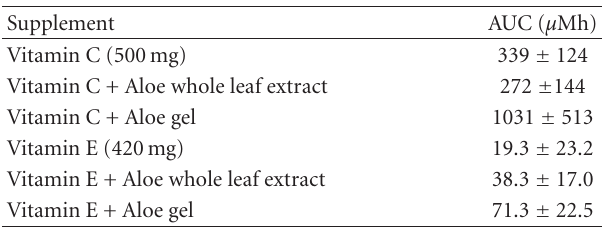
Table 27: AUC of vitamins C and E alone or with Aloe gel or Aloe whole leaf extract [196].